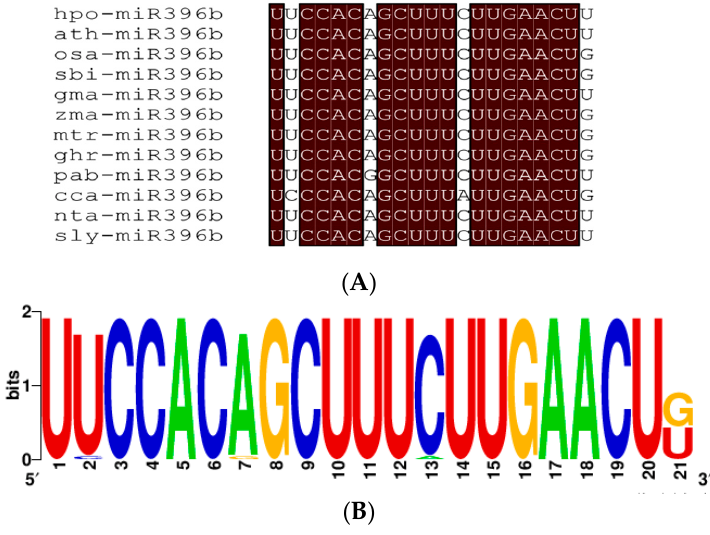
Figure 4. Conserved nucleotide sequence analysis of plant miR396b : ( A ) alignment of the logo sequence of miR396b from twelve plant species whose names are H. polyrhizus ( hpo-miR396b ), A. thaliana ( ath-miR396b ), O. sativa ( osa-miR396b ), Sorghum bicolor ( sbi-miR396b ), Glycine max ( gma-miR396b ), Zea mays ( zma-miR396b ), Medicago truncatula ( mtr-miR396b ), Gossypium hirsutum ( ghr-miR396b ), Picea abies ( pab-miR396b ), Cynara cardunculus ( cca-miR396b ), Nicotiana tabacum ( nta-miR396b ), and Solanum lycopersicum ( sly-miR396b ), respectively. Nucleotides that are identical are highlighted in dark red background; ( B ) the logo sequence of miR396b , and the height of the letter at each position represents the degree of conservation.